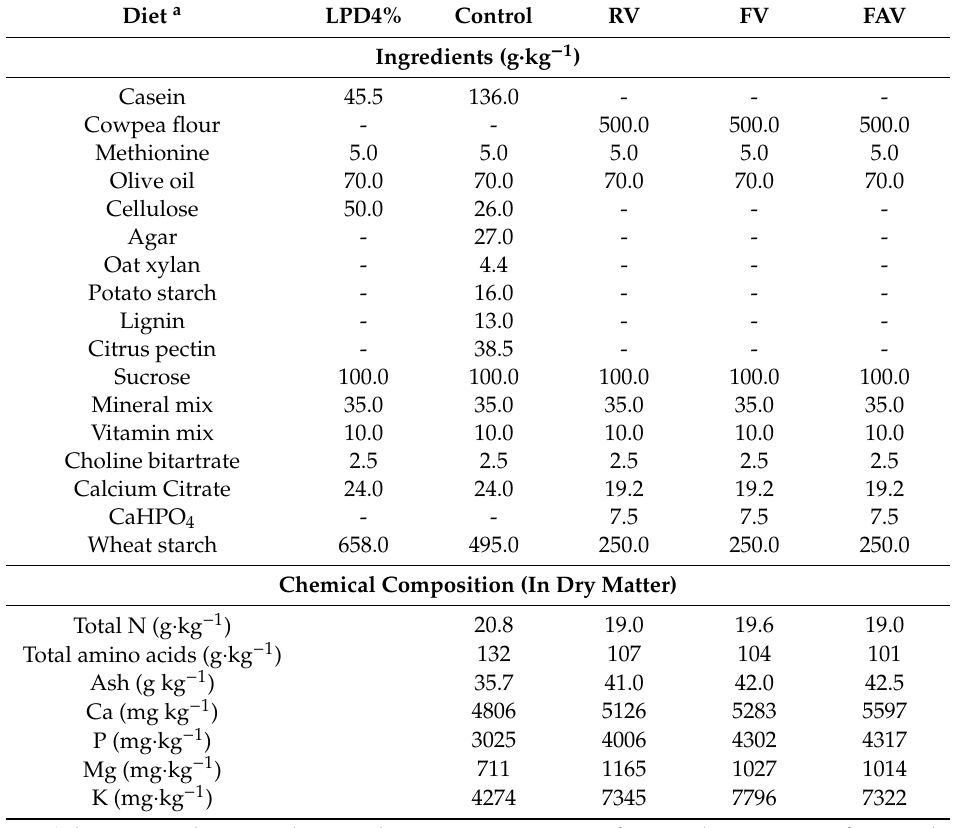
Table 1. Composition of the experimental